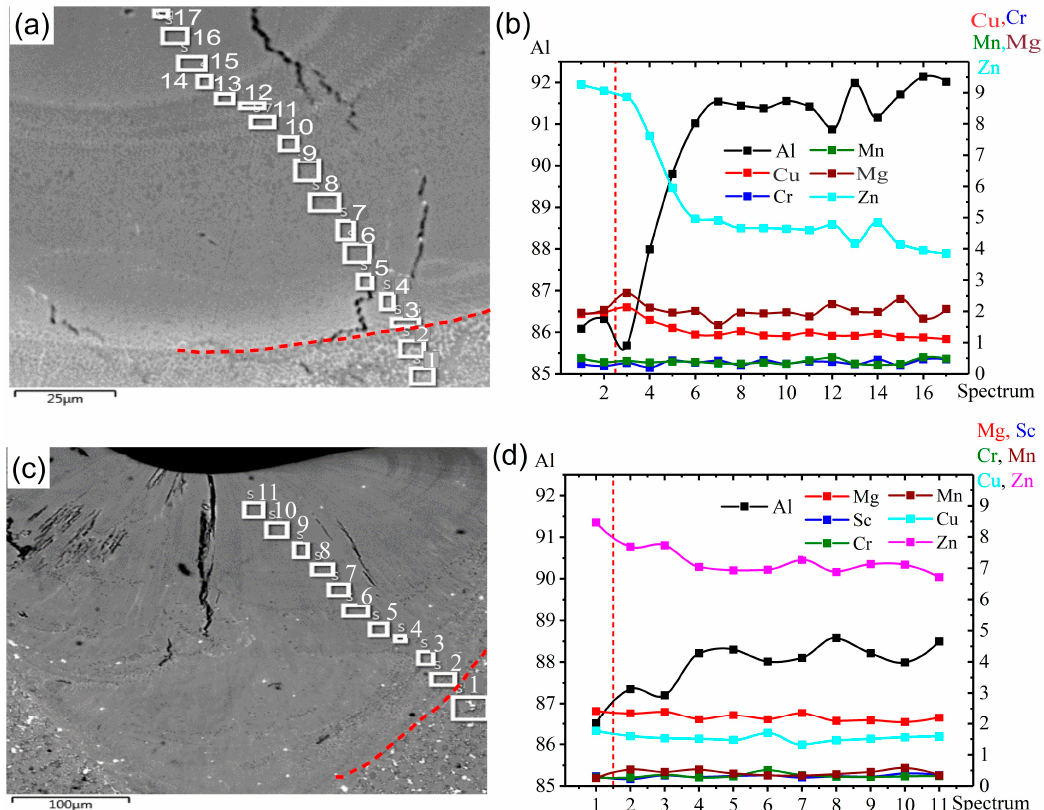
Figure 9. The concentration of the elements at different points along the LMZ after homogenization annealing at 460 °C for 3 h: ( a , b ) AA7075-standard, ( c , d ) AA7075-ScZr.